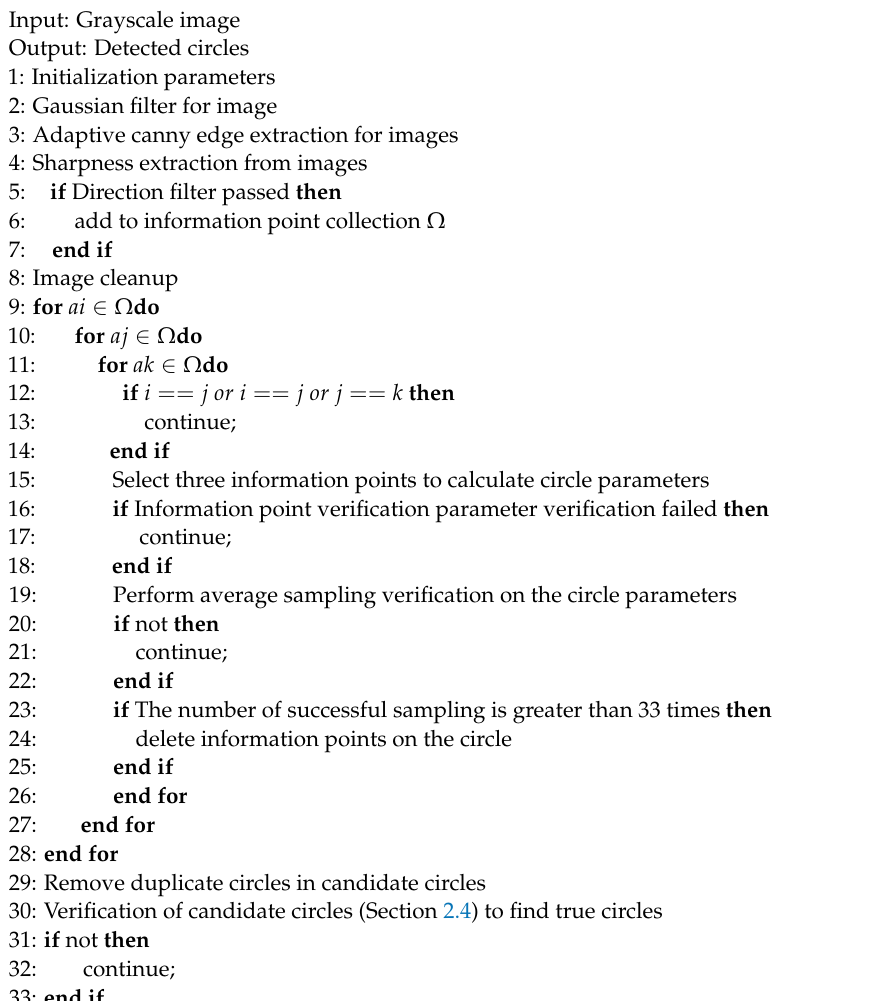
Algorithm 1 : Proposed Circle Detection